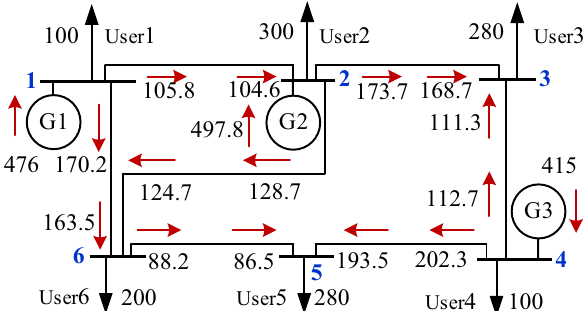
Figure 2. Steady-state power flow distribution of 6-bus test system.